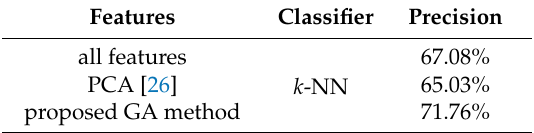
Table 4. Comparison of average precision of related stress classification from the EEG